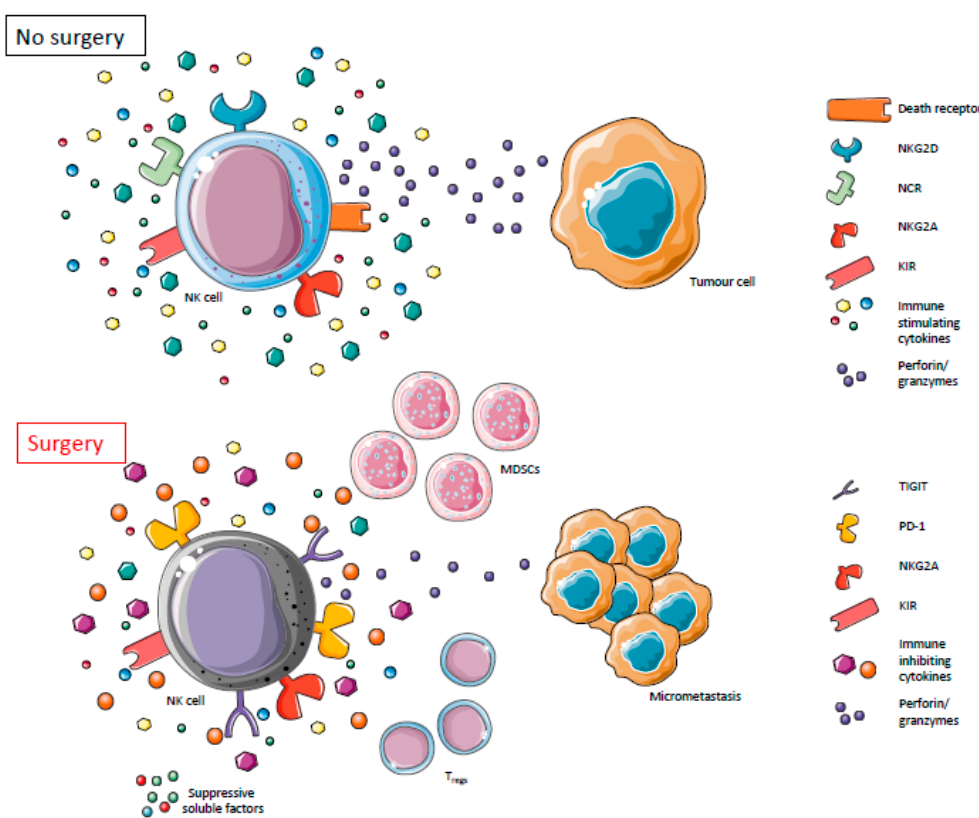
Figure 1. Natural Killer (NK) cells effector functions are impaired postoperatively. In the absence of surgery, NK cells are able to appropriately exert their effector functions thereby directly and indirectly acting to suppress tumor growth and proliferation. In the postoperative period, however, NK cell function is suppressed, leading to a metastatic formation in cancer surgery patients. In our proposed model, surgically stressed NK cells undergo changes in receptor expression mediated by stress-induced soluble factors and surgery-induced suppressive cell populations.